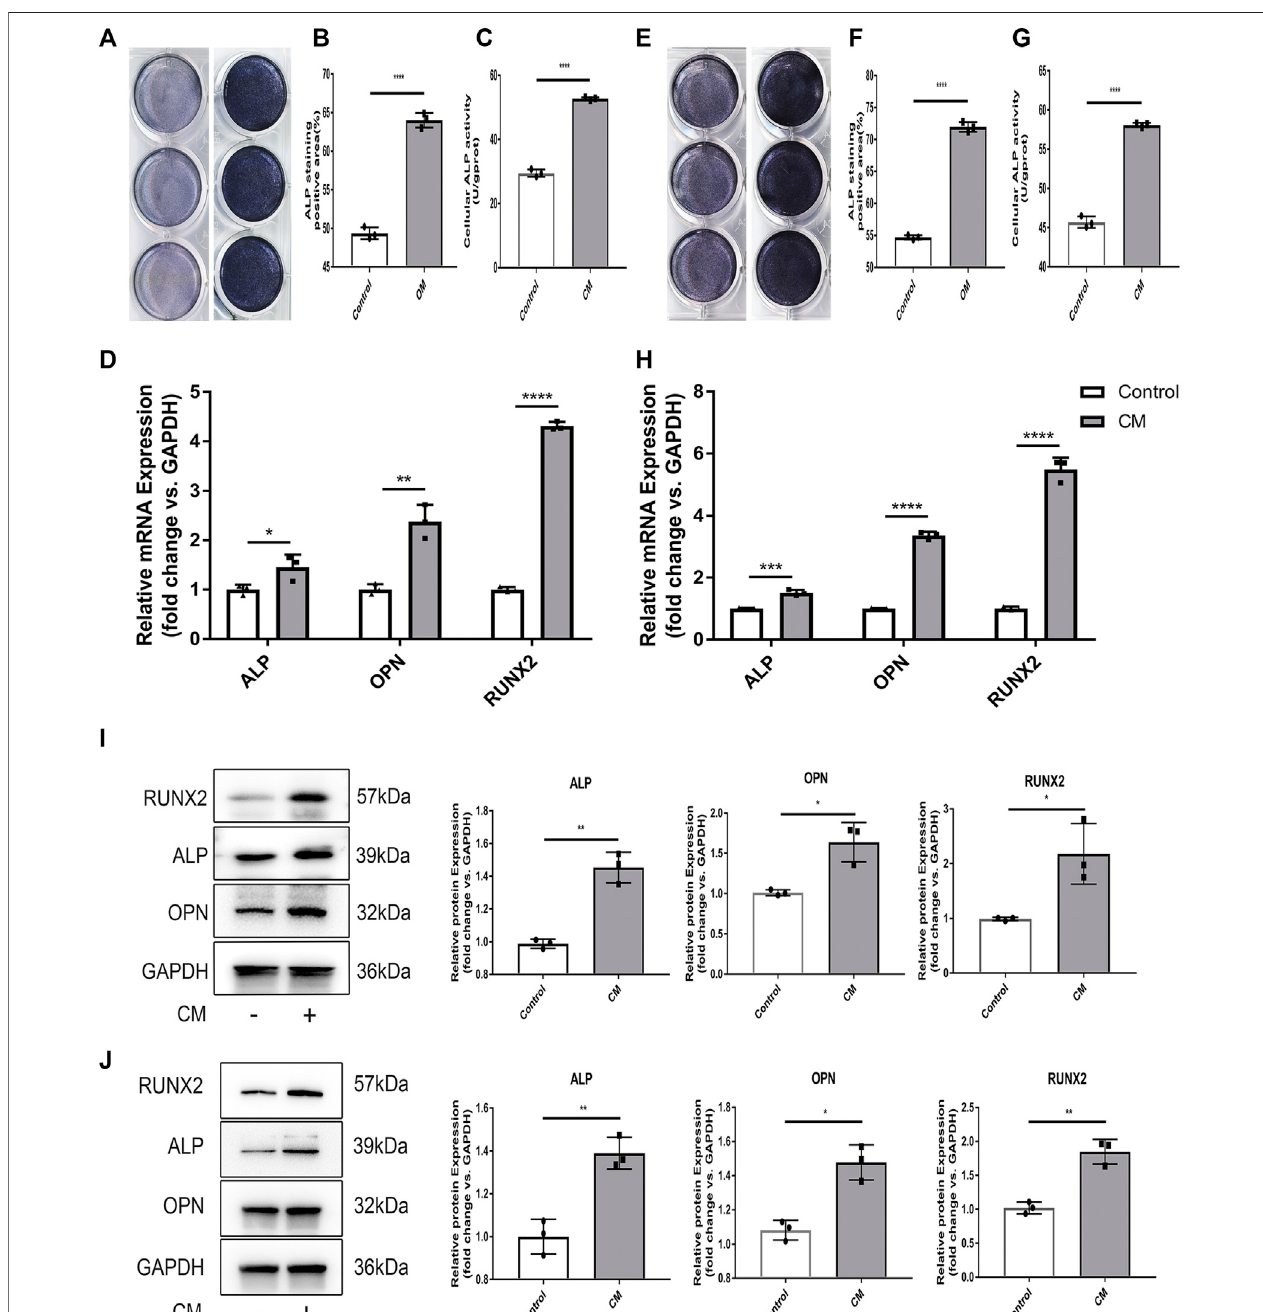
FIGURE3| Mechanicaltensionpromotesosteocyte-mediatedosteogenesis. (A) ALPstainingof3T3-E1afterinductionofdifferenationwithCMfromMLO-Y4. (B) Thequanti fi cationofALP+surface/B.Pm(%)of3T3-EIafterinductionofdifferentiationwithCMfromMLO-Y4. (C) CellularALPactivity(U/gprot)of3T3-E1afterinduction ofdifferentiationwithCMfromMLO-Y4. (D) TheexpressionlevelofosteoblasticmarkersasALPOPNRUNX2of3T3-E1wasdetectedbyRT-PCR.GAPDHwasusedfor normalization. (E) ALP staining of primary osteoblast precursor cells after induction of differenation with conditioned medium (CM) from MLO-Y4. (F) The quanti fi cationofALP+sueface/B.Pm(%)ofprimaryosteoblastprecursorcellsafterinductionofdifferentiationwithCMfromMLO-Y4. (G) CellularALPactivity(U/gprot)of primary osteoblast precursor cells after induction of differentiation with CM from MLO-Y4. (H) The expression level of osteoclastic markers of as ALP OPN RUNX2 of primary osteoblast precursor cells was detected by RT-PCR. GAPDH was used for normalization. (I) The protein expression of ALP OPN and RUNX2 of 3T3-E1 were measuredbywesternblot.Thequanti fi cationofALPOPNandRUNX2.GAPDHwasusedfornormalizatio. (J) TheproteinexoressionofALPOPNandRUNX2ofprimary osteoblast precursor cell were measured by western blot. The quanti fi cation of ALP OPN and RUNX2. GAPDH was used for normalization. All cell experiment were repeated 3 times and each time they were performed at least 3.